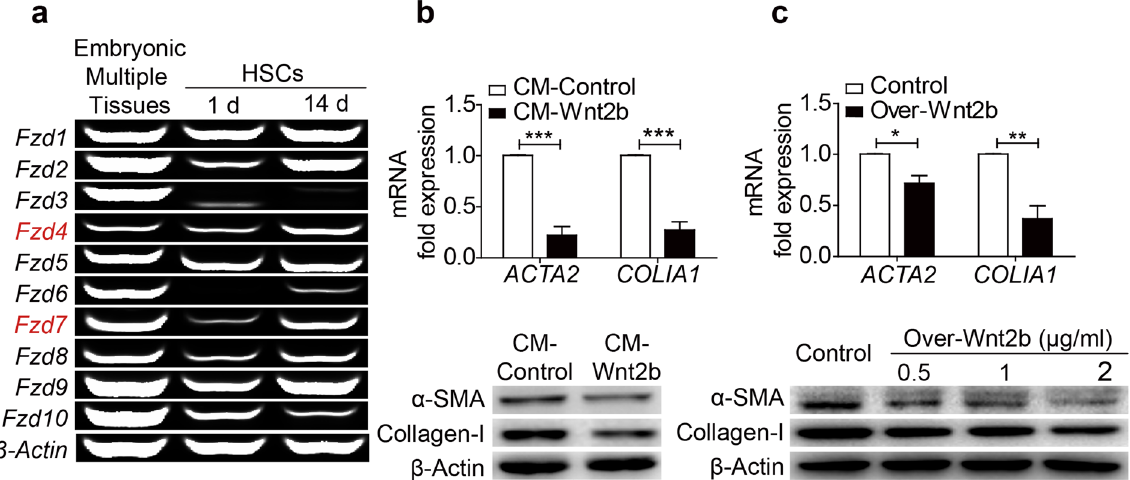
Figure 4. Wnt2b exerts a direct inhibitory effect on HSCs activation. ( a ) RT-PCR analysis of Fzds and LRP5/6 in cultured HSCs from naive mice at the indicated points of time. Mouse embryonic tissues served as positive controls. ( b , c ) mRNA and protein levels of α -SMA and Collagen-I in LX2 cells cultured in conditioned medium (CM) collected from HEK293 cells transfected with active Wnt2B-V5 (CM-Wnt2b) or control plasmid (CM- Control) ( b ), as well as in LX2 cells transfected with active Wnt2B-V5 or control plasmid ( c ). Cropped blots are displayed; Full-length blots are presented in Supplementary Fig. S6. Data are mean ± SEM of three independent experiments; * P < 0.05, ** P < 0.01, *** P <